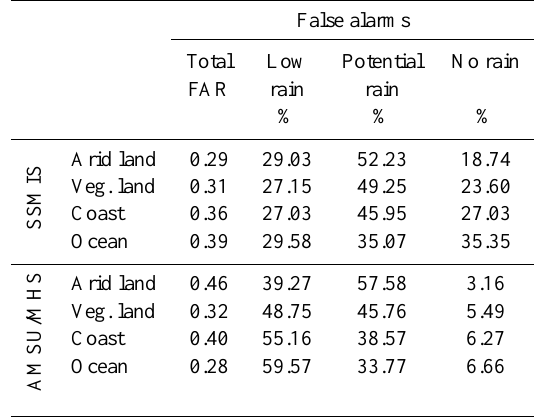
Table 4. Probability of detection scores classified by surface back- Table 6. False alarms ratio scores classified by surface and rain flag. ground and rain type. Percentages represent the fraction of false alarm counts for a given surface type and rainFlag w.r.t the total number of false alarms for each surface POD Convective Stratiform Shallow Other Mixed Arid land 0.61